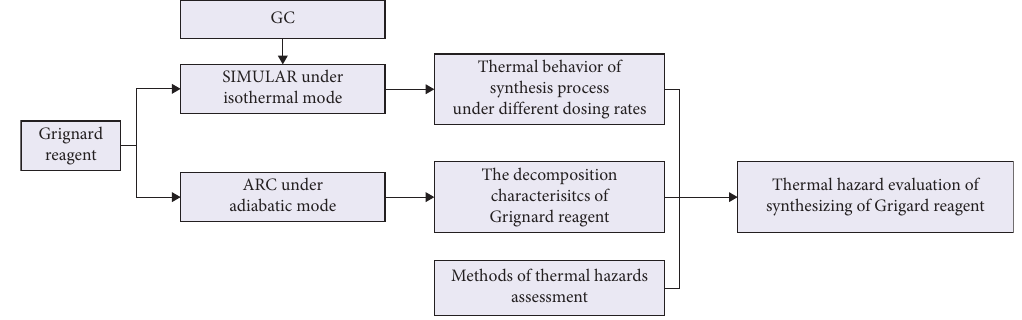
Figure 2: Experimental diagram. Table 1: Chemicals used in the synthesis